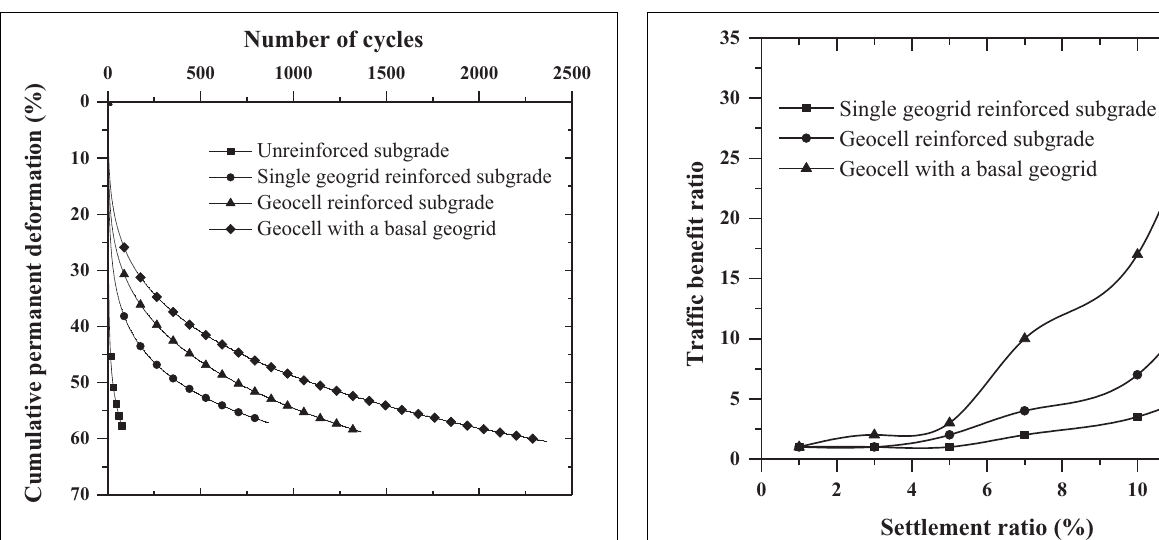
FIGURE 8 | Variation of cumulative permanent deformation with number of cycles.